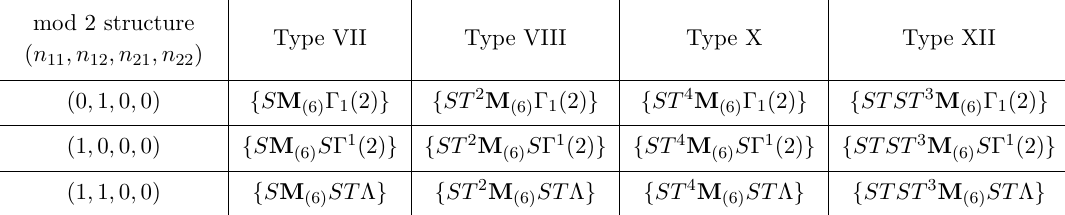
Table 16 . Classification of Types VII, VIII, X, XII for D = 6